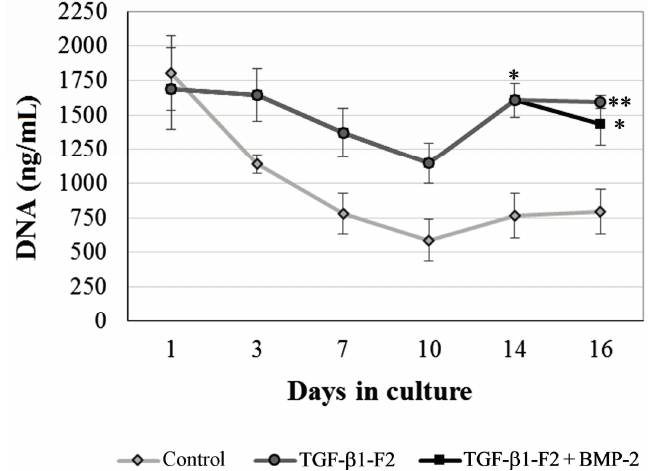
Figure 1. Quantification of DNA content as indication of cell replication. Values represent the means ± SD, n = 3; * p < 0.05, ** p < 0.01.